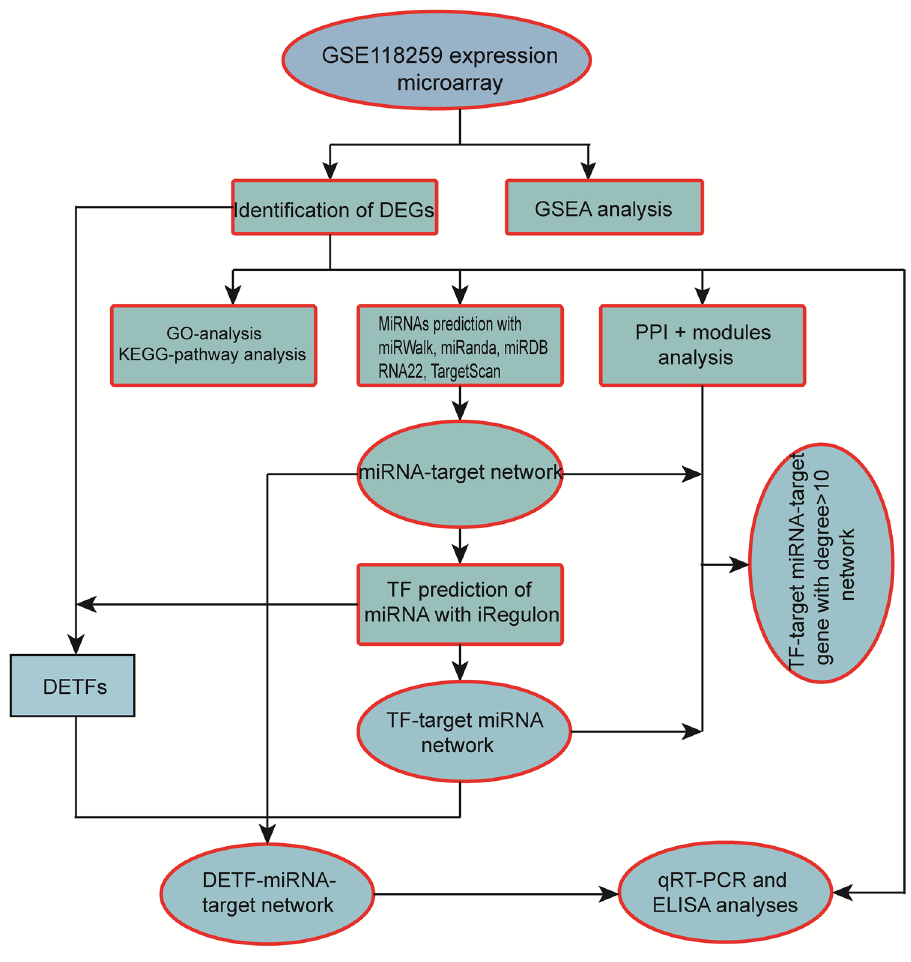
Figure 1. Flow diagram of the analysis